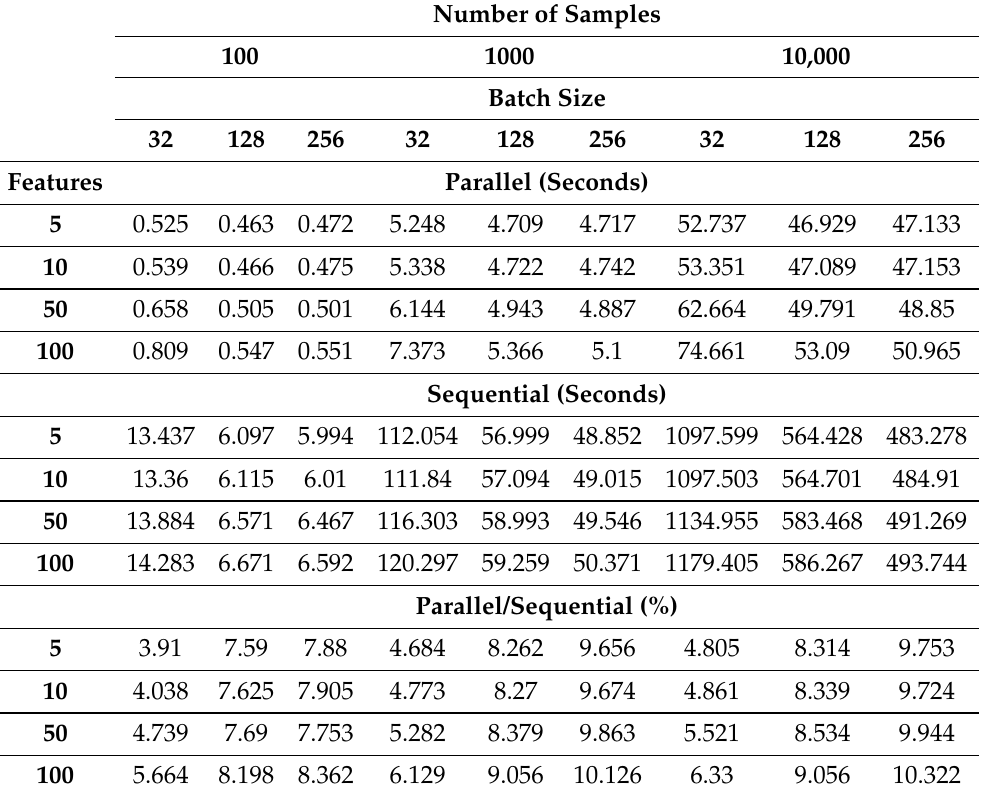
Table 1. Average of 10 epochs to train 10,000 models using a